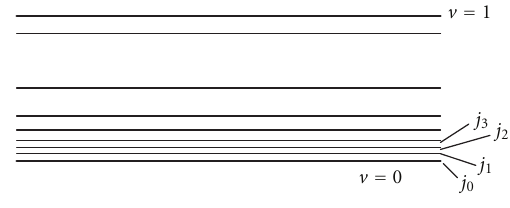
Figure 3: Illustration of rotational states as sublevels of v = 0 state. with 500 W Xenon lamp), Bausch and Lomb